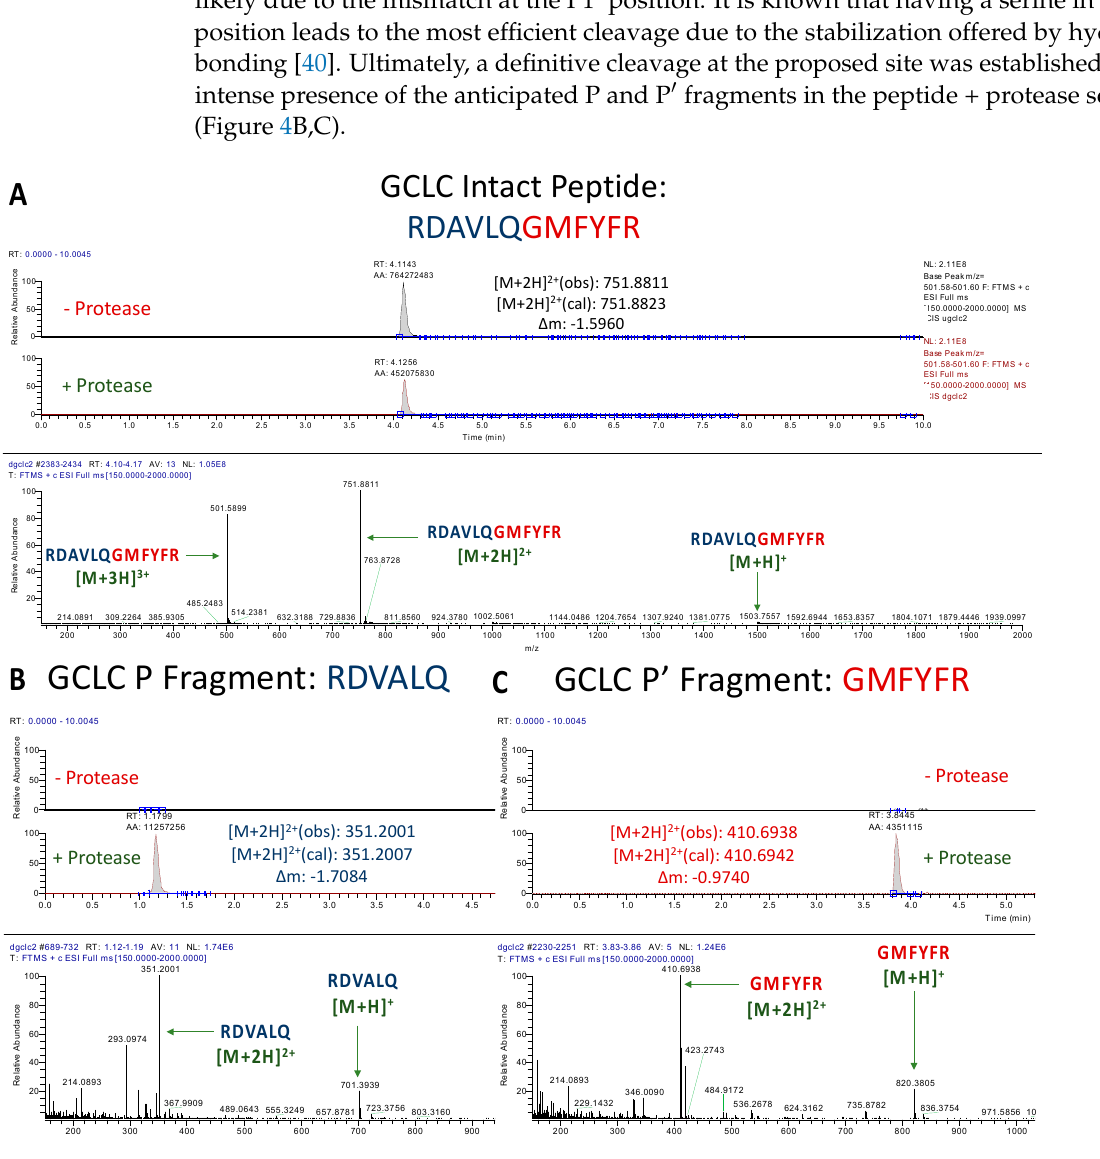
Figure 4. UPLC-MS Data for GCLC Peptide. Depicted are the extracted ion chromatograms for the samples without protease and with protease (top) and the mass spectra (bottom) for ( A ) the Intact Peptide, ( B ) the P Fragment, and ( C ) the P ′ Fragment. Normalization levels of the base peaks for the P and P ′ fragments were 3.20 × 10 6 and 1.40 × 10 6 , respectively. High resolution mass spectrometric analysis corroborates the identities of each base peak in the corresponding ion chromatogram.